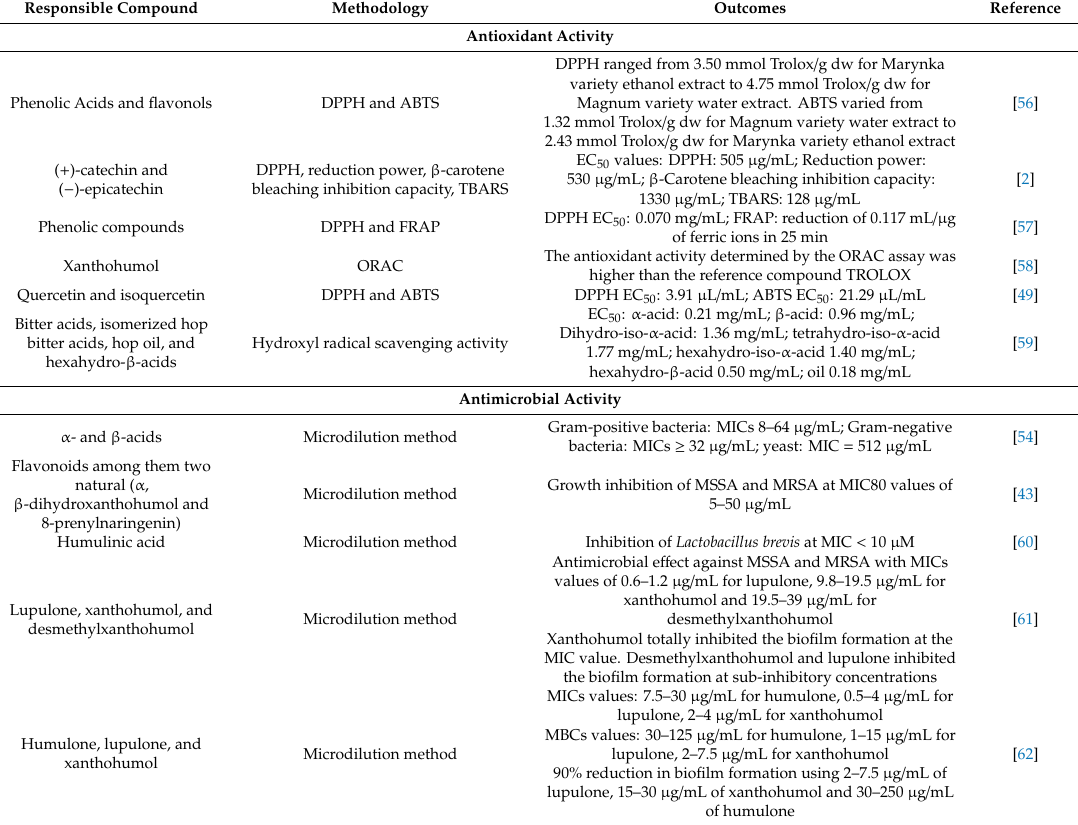
Table 2. Biological activities of compounds extracted from